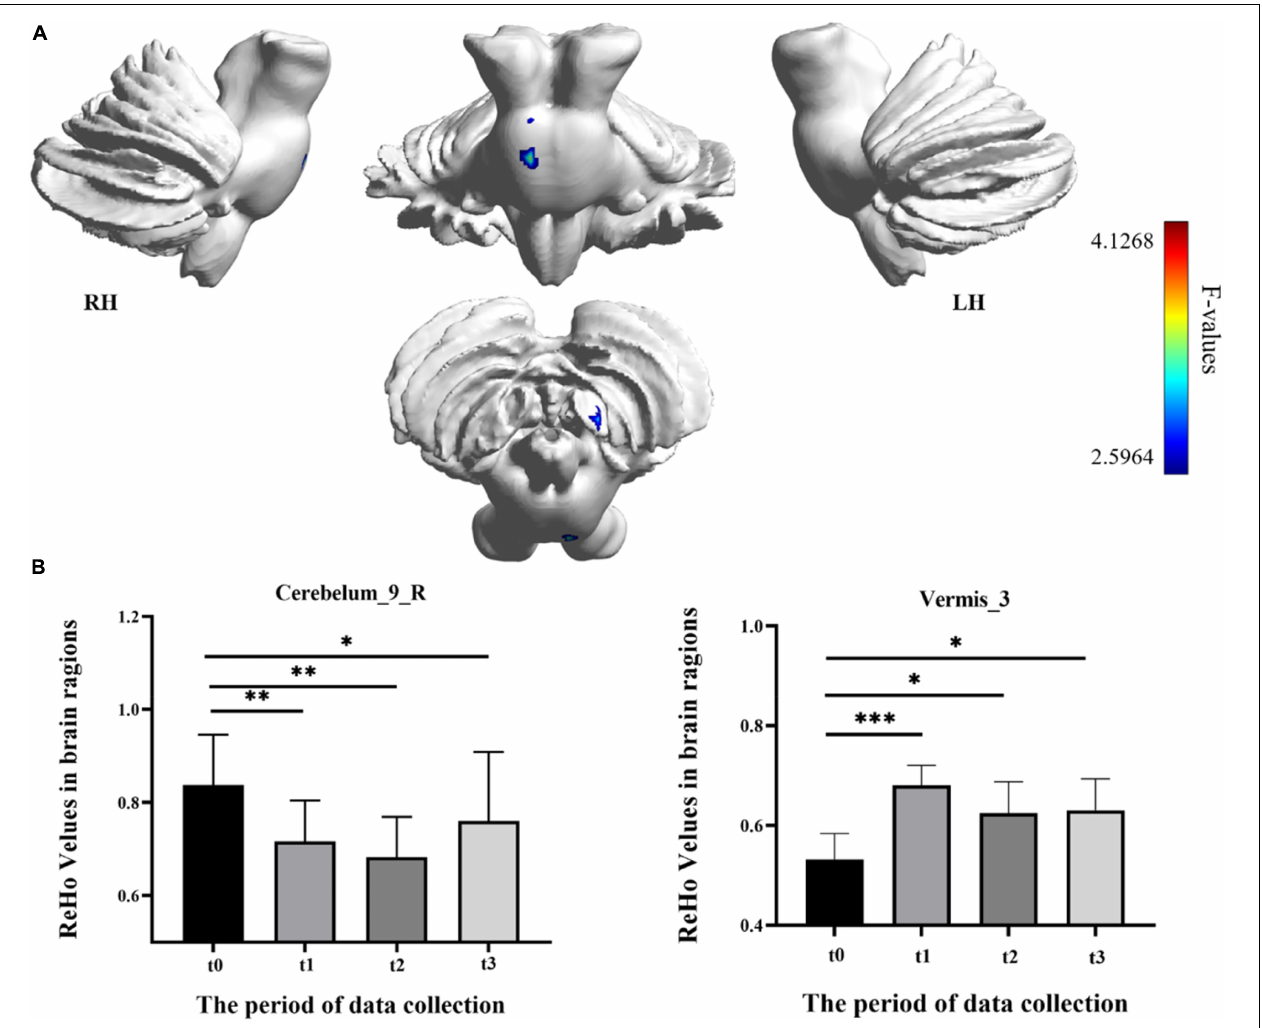
FIGURE 4 | Regional homogeneity (ReHo) differences among different time-subgroups. (A) One-way repeated-measure ANOVA showed brain regions with ReHo differences among four subgroups in the Cerebelum_9_R and Vermis_3. The color bar indicated the F scores. (B) Bar plots showed the ReHo values of the Cerebelum_9_R at four different time-subgroups. Cerebelum_9_R, right cerebellum posterior lobe IX; Vermis_3, cerebellum anterior lobe III; t0, t1, t2, and t3, different time subgroups; LH, left hemisphere; RH, right hemisphere, ∗ indicates a significant difference in the two groups. ∗ p < < 0.05, ∗∗ p < 0.01, ∗∗∗ p <